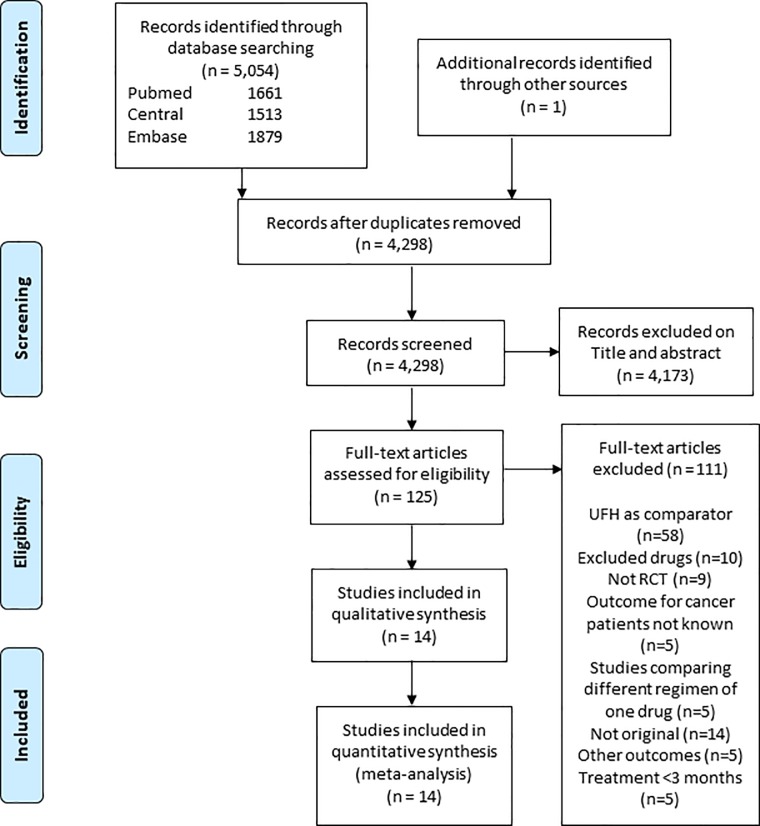
Study flow chart.